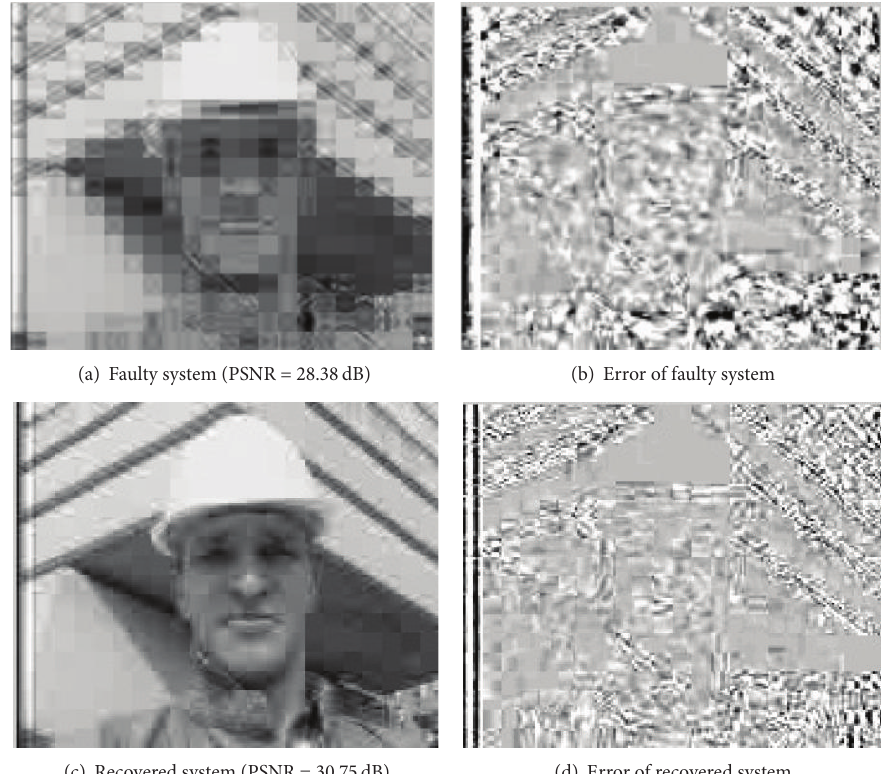
Figure 14: Partial recovery results of the